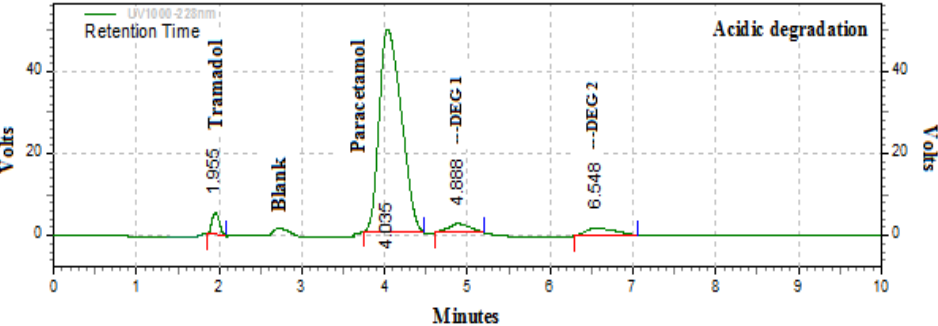
Figure 3. Representative chromatogram obtained from Acidic degradation (0.1 N HCl).